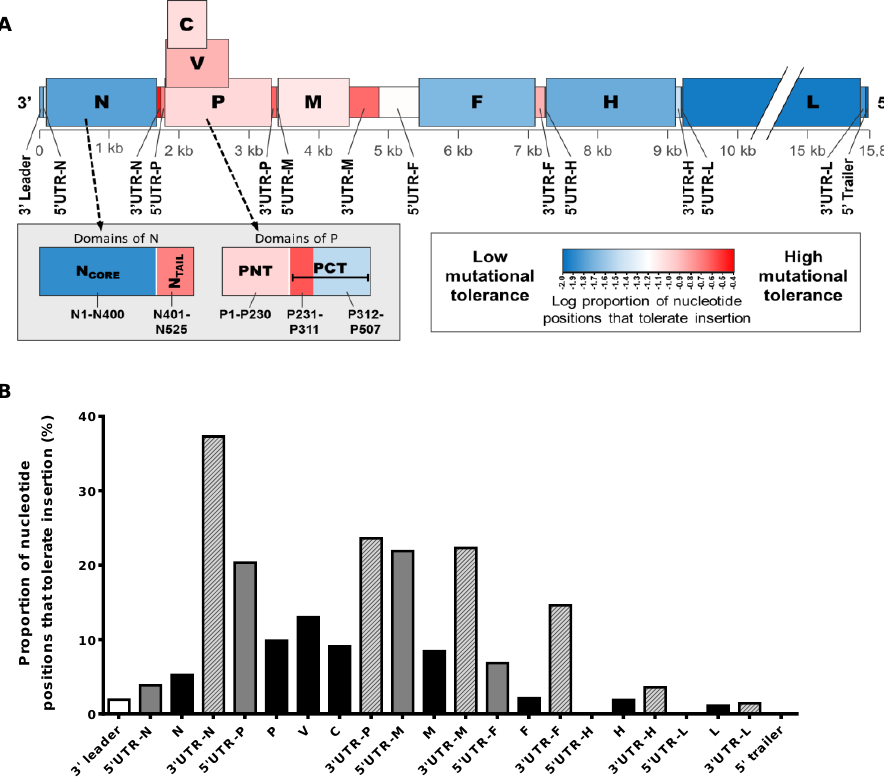
Figure 2. Tolerance for insertional mutagenesis in different regions of the MeV genome. The number of positions that tolerate transposon-mediated insertional mutagenesis in each region of the genome were normalized to the length of the region to determine insertional tolerance. ( A ) Schematic representation of the MeV genome organization, with each region colored according to its mutational tolerance. UTR = untranslated region. Grey inset box shows the mutational tolerance of different domains within N and P, with residue numbers indicated below each respective domain; PNT = N-terminal domain of P; PCT = C-terminal domain of P. ( B ) Quantification of tolerance for insertional mutation in different genomic regions. Data obtained from Fulton et al. (2015)